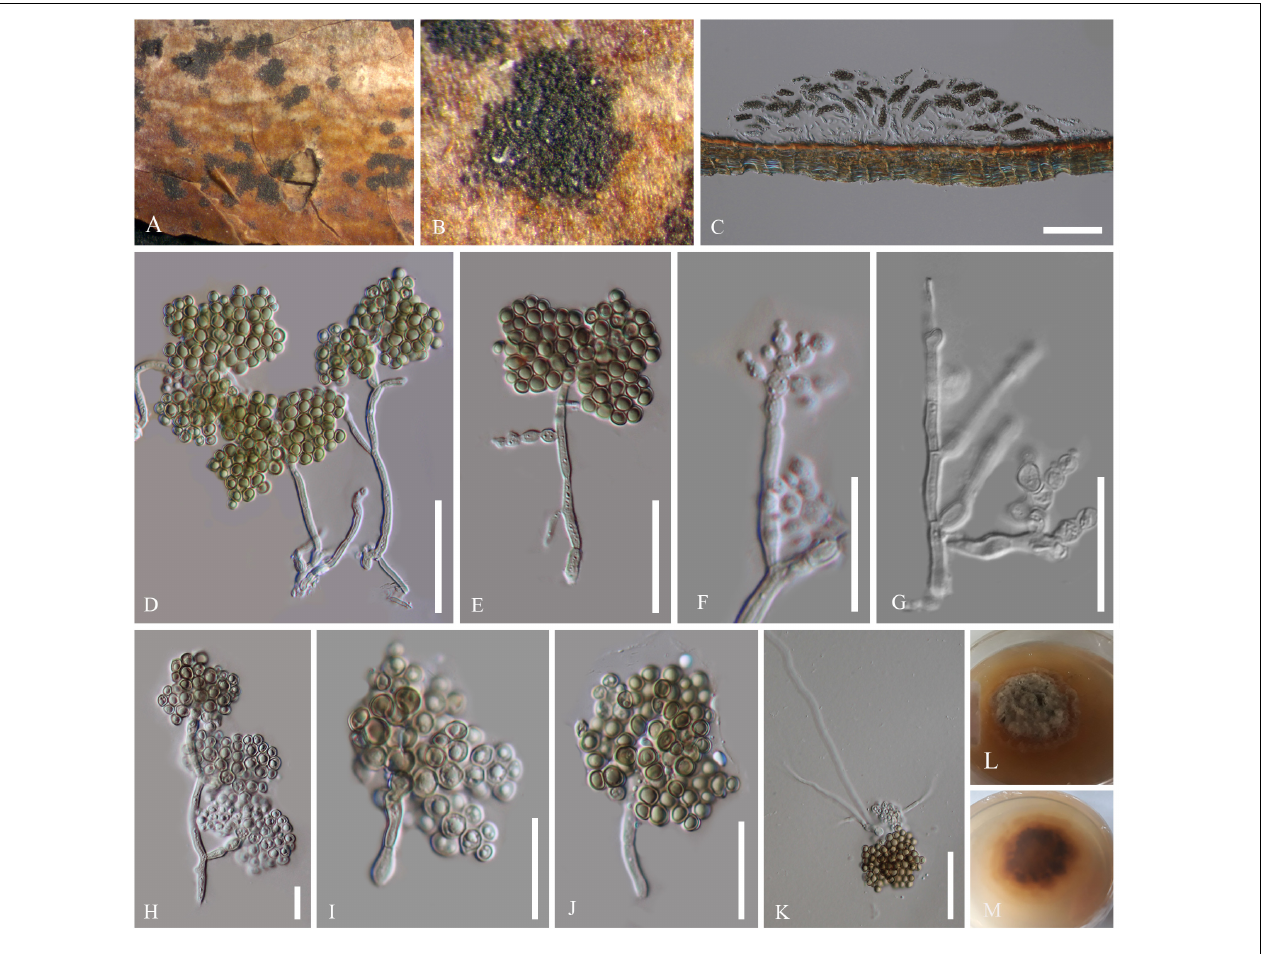
FIGURE 2 | Asexual morph of Patellariopsis atrovinosa (MFLU 16-2950). (A,B) Appearance of sporodochium on host substrate. (C) Longitudinal section of sporodochium. (D) Conidiophore attached to the host. (E–G) Various stages of conidiogenesis. (H–J) Conidia. (K) Germinated conidium. (L,M) Culture characteristics on PDA ( L = from above, M = from below). Scale bars: C = 50 µ m; D,E = 20 µ m; F–K = 10 µ